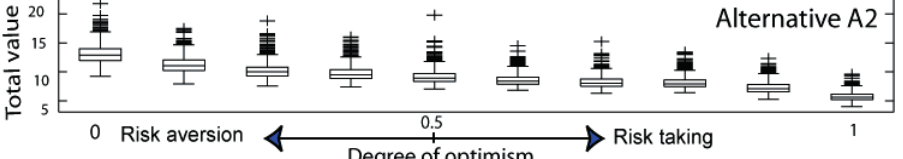
Fig. 5 The MCS sensitivity analysis for various optimism degrees ( θ ), on the total performance values of the alternatives (A1, A2 and